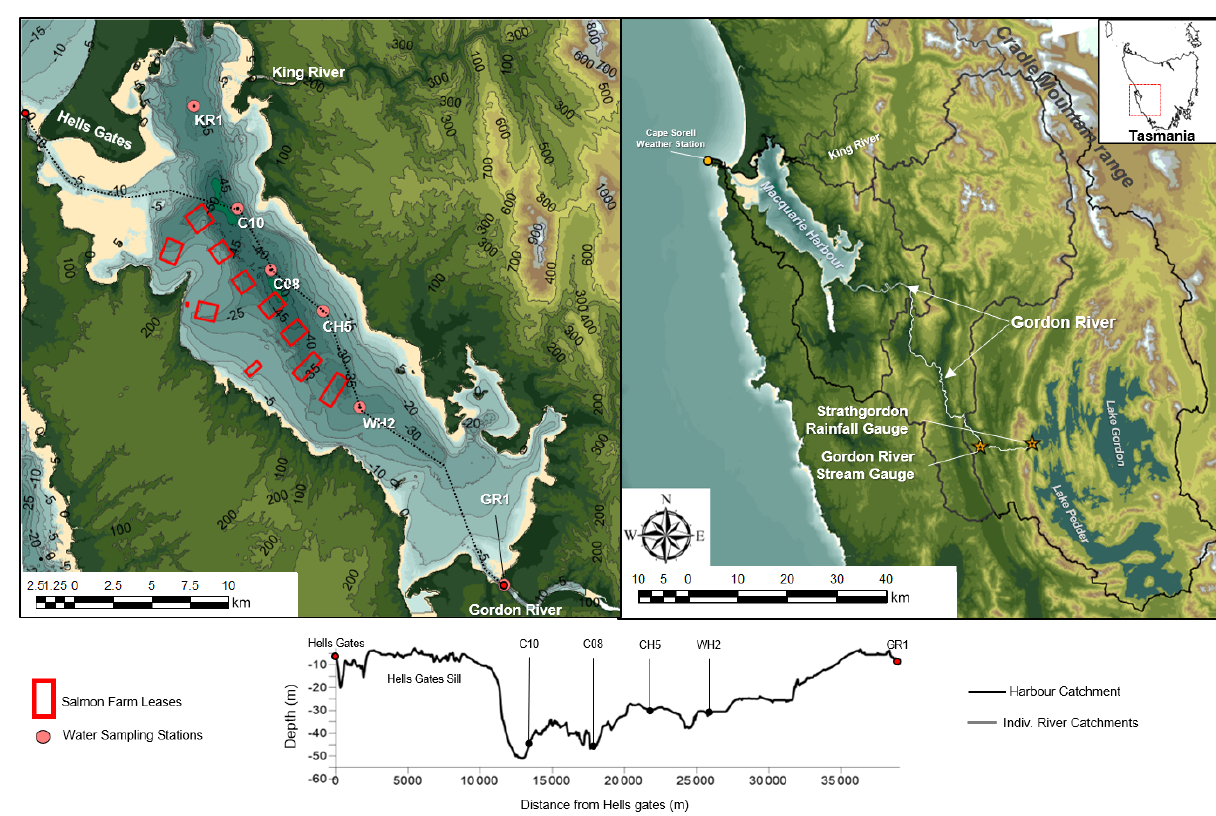
Figure 1. Macquarie Harbour, Tasmania. Monthly sampling sites shown with red circles, and Gordon River Stream Gauge and Strathgordon rainfall gauge are shown as orange stars. Aquaculture lease boundaries are shown as hollow red rectangles. Lease locations are sourced from Land Information Systems Tasmania (LISTmap – https://maps.thelist.tas.gov.au/, last access: 23 June 2022). Station names reflect general harbour locations, in which KR1 indicates King River 1; C10, C08, and CH5 indicate Central Harbour 10, 08, and 5; WH2 indicates World Heritage Area 2; and GR1 indicates Gordon River station